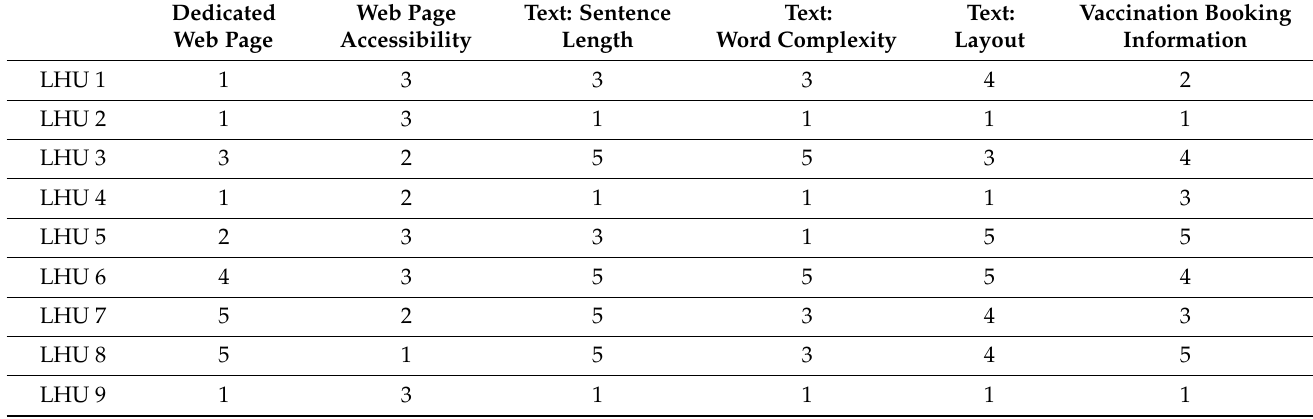
Table 2. Overall results of the web page analysis, by the Local Health Unit (LHU), according to the scores detailed in Table S1. The range of numbers is [1 = critical lack; 2 = lacking content; 3 = improvable content; 4 = suboptimal content; 5 = optimal].